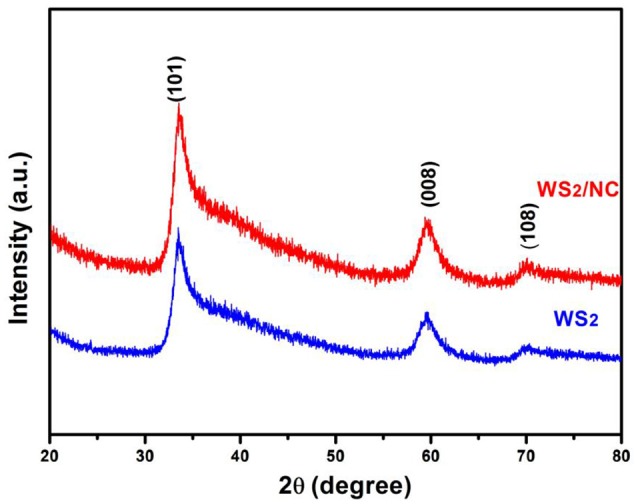
XRD patterns of the as-prepared WS2/NC and WS2.